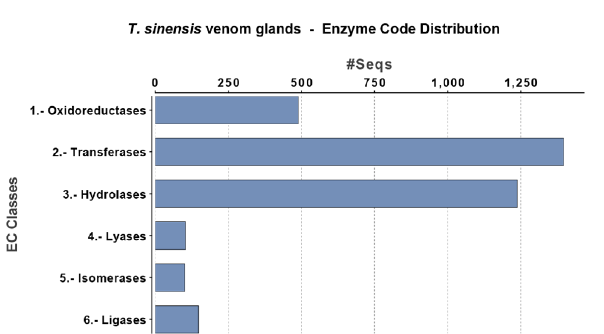
Figure 4. Gene Ontology sequence annotation of T. sinensis 195 venom proteins. Gene Ontology (GO) assignments for the T. sinensis venom proteins. GO assignments as predicted for their involvement in ( a ) biological processes and ( b ) molecular functions. All data are presented at level 4 GO categorization. Classified gene objects are depicted as absolute numbers and percentages (in brackets) of the total number of gene objects with GO assignments. In ( c ) enriched distribution of Gene Ontology (GO) terms in T. sinensis venom proteins were identified. Bar charts show the GO terms that were significantly (false discovery rate (FDR) < 0.05) enriched in the group of venom proteins compared to the complete T. sinensis gland transcriptome. The GO terms are sorted in an ascending order according to their FDR value, starting with the most significantly enriched. Only the most specific GO terms are displayed. Differences are shown as the percentage of sequences associated with a specific GO category in the test set (venom protein-encoding contigs) versus the reference set (transcriptome backbone assembly) using Fisher’s exact test in OmicsBox.